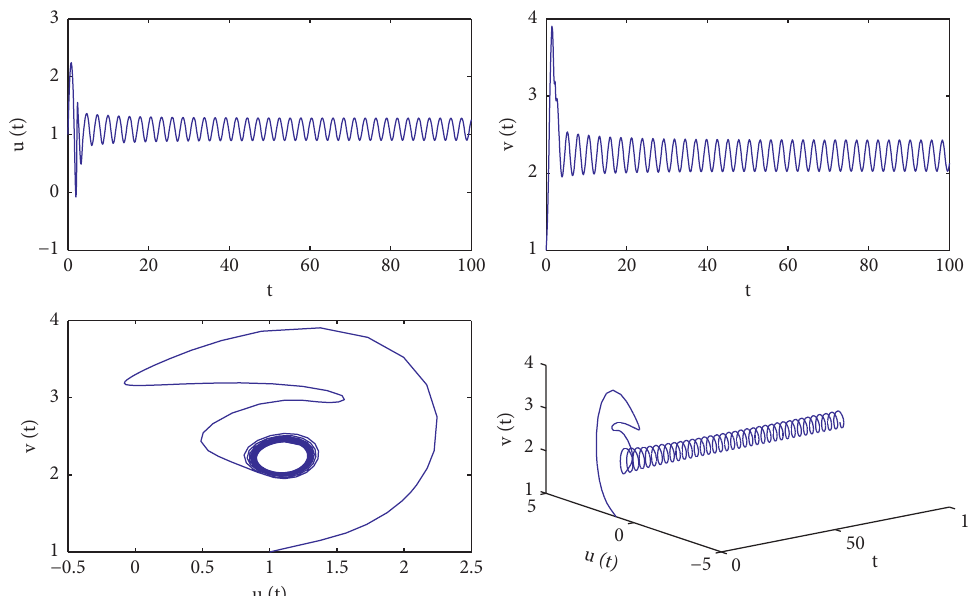
Figure 7: The trajectories graphs and phase graphs of system (94) with τ ( 1 , 1 )